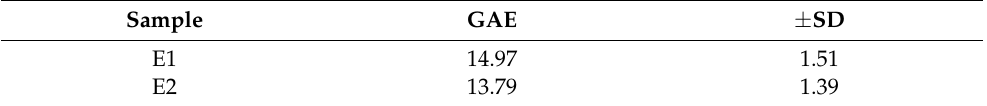
Table 6. Total phenolics compounds contained in C. sativa cv. strawberry